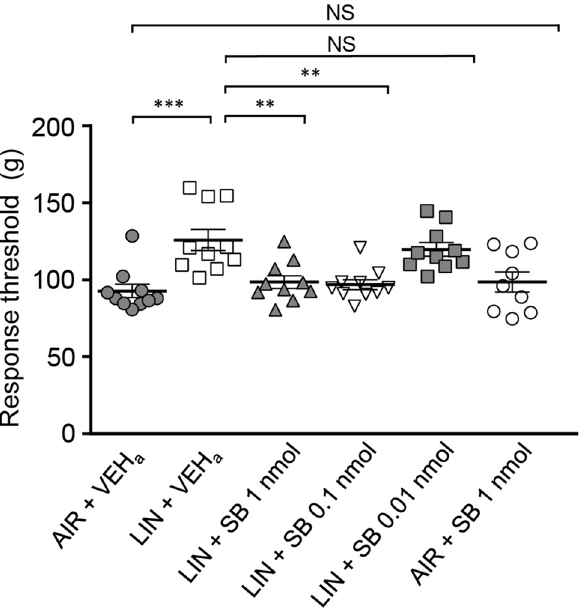
Figure 4. Intrathecal injection of SB 334867 suppressed linalool odor-induced analgesia in the tail pincher test. Each group consisted of 10 mice except for AIR + SB 1 nmol group ( n = 9). AIR; odorless air exposed mice, LIN; linalool odor-exposed mice, VEH a ; mice which received intrathecal injection of vehicle for antagonist, SB; mice which received intrathecal injection of OX1 receptor antagonist. Bars represent mean ± SEM. *** p < 0.0005; ** p < 0.005 (Tukey’s multiple comparison test).